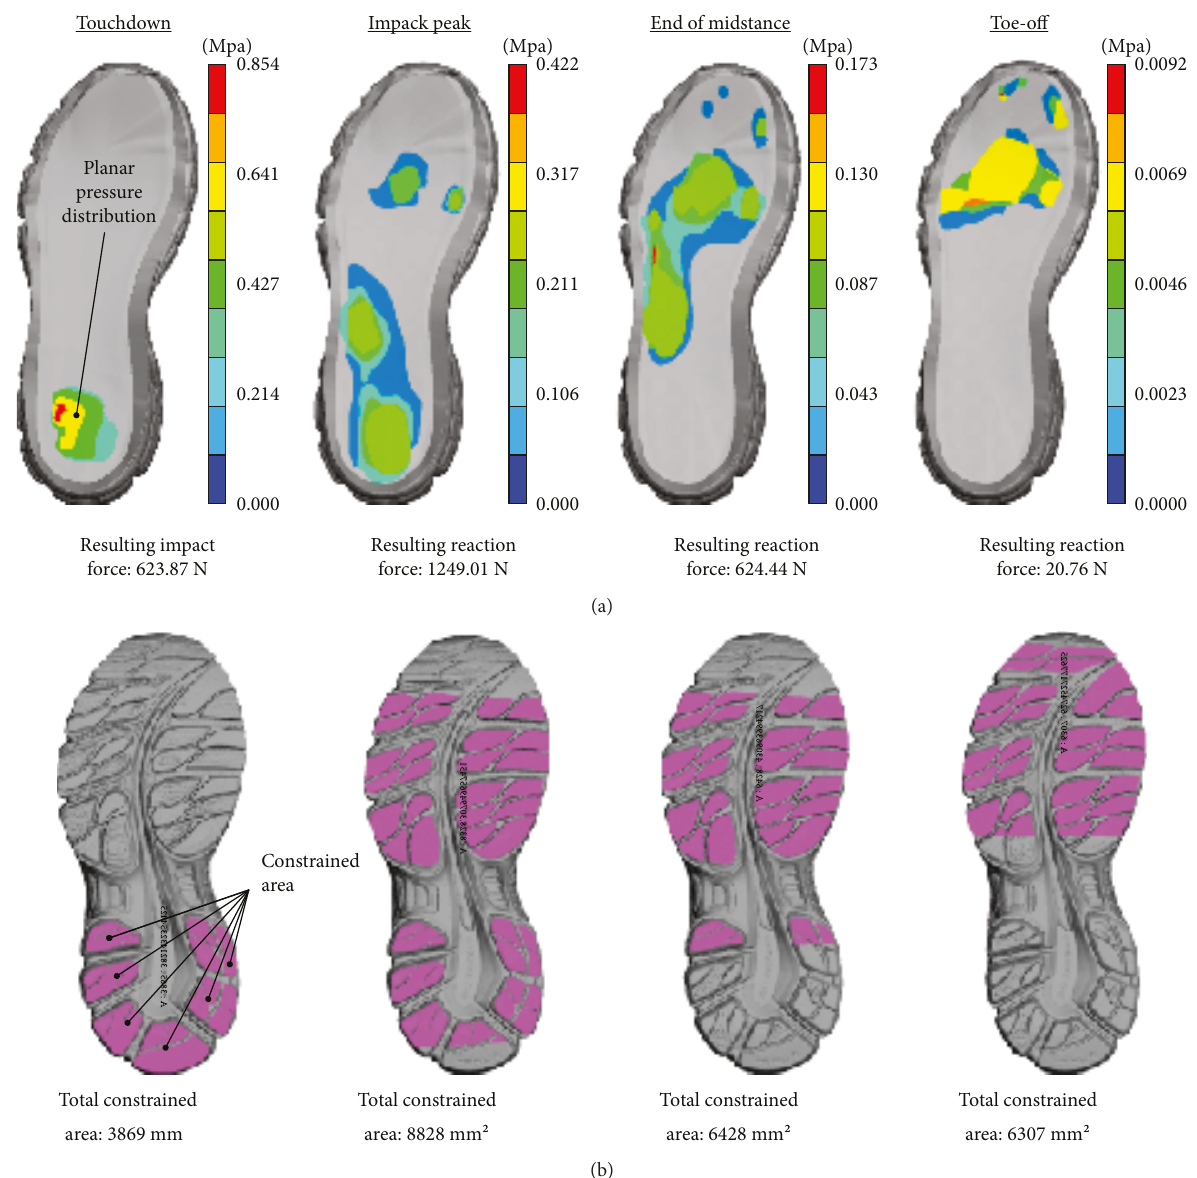
Figure 2: (a) Indicative load steps and (b) subshoe boundary condition considered during the